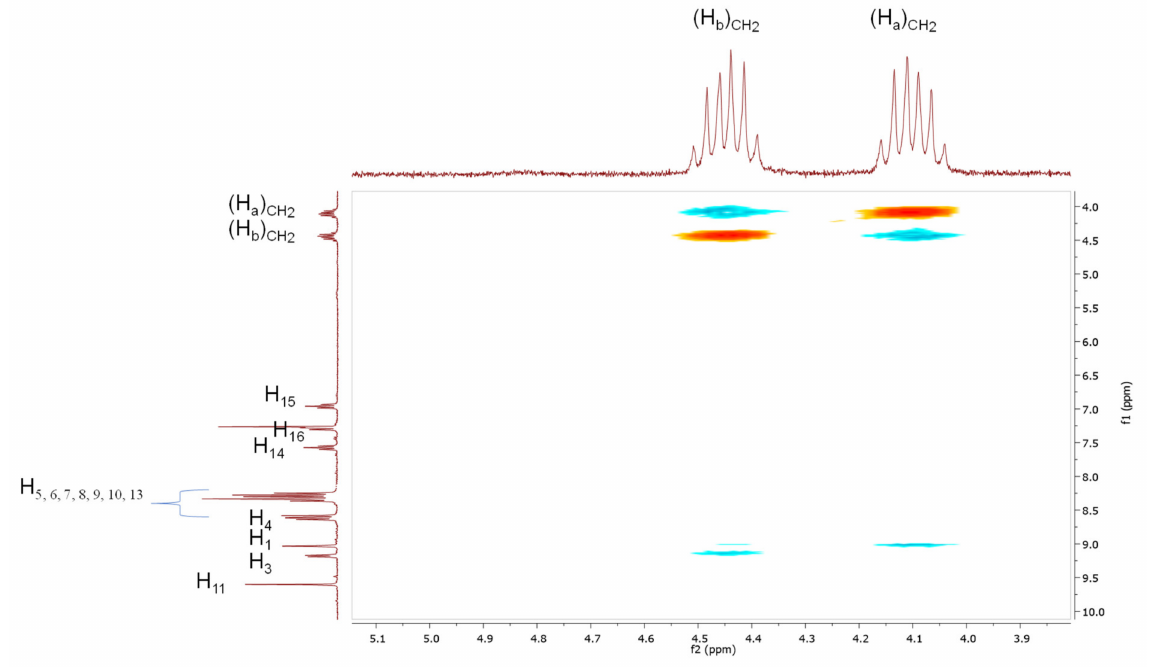
Figure 7. NOESY experiment on 7 .